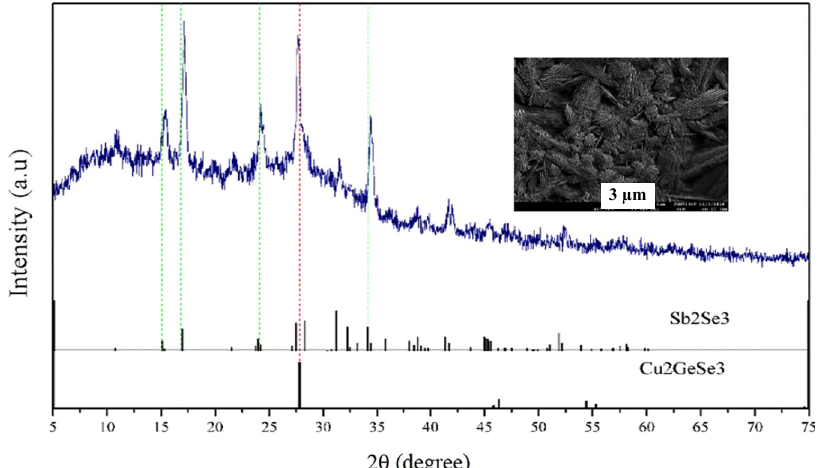
Fig. 2. The X-ray diffraction pattern and the morphology of crystallized 40GeSe 2 – 40Sb 2 Se 3 – 20CuI thin fi lm. The diffraction peaks can be assigned to the orthorhombic phases for Sb 2 Se 3 (JCPDS 75-1462) and Cu 2 GeSe 3